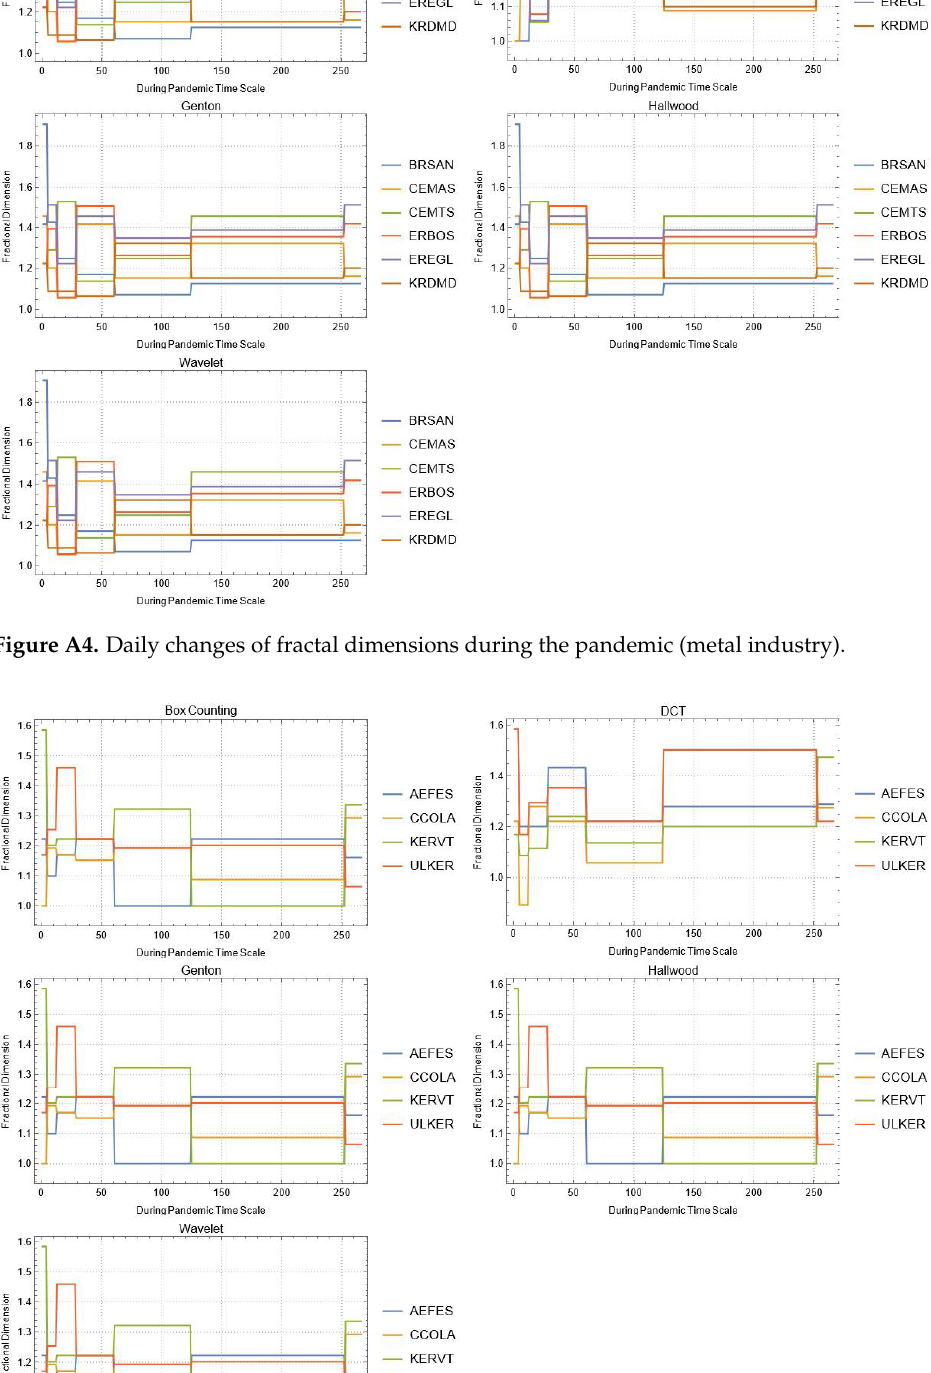
Figure A5. Daily changes of fractal dimensions during the pandemic (food, beverage and tobacco).